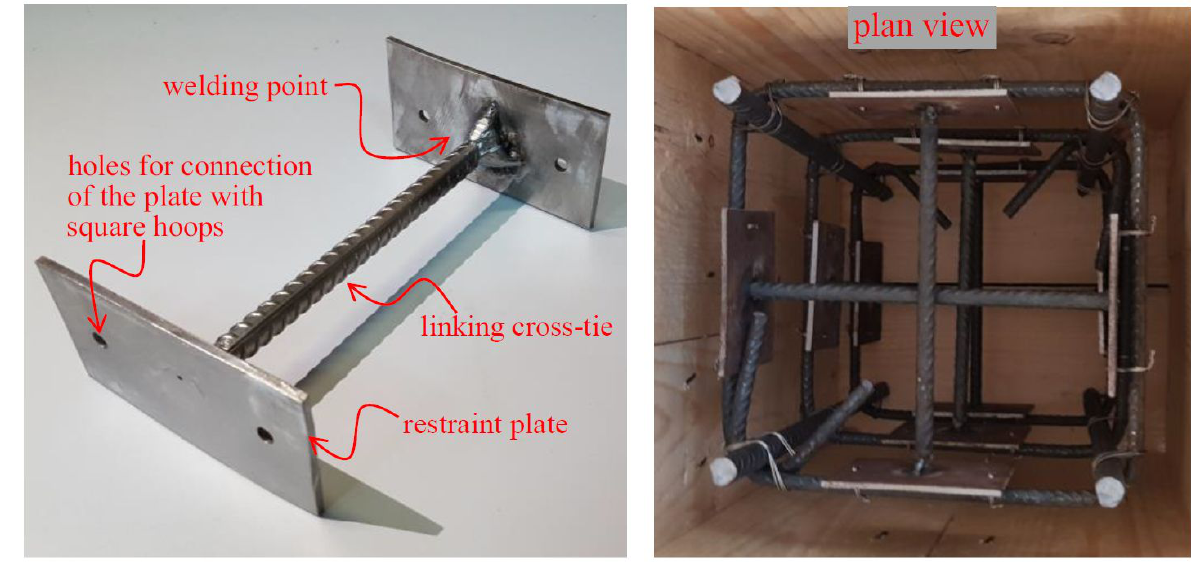
Figure 3: Close-up details of the novel RP transverse reinforcement scheme